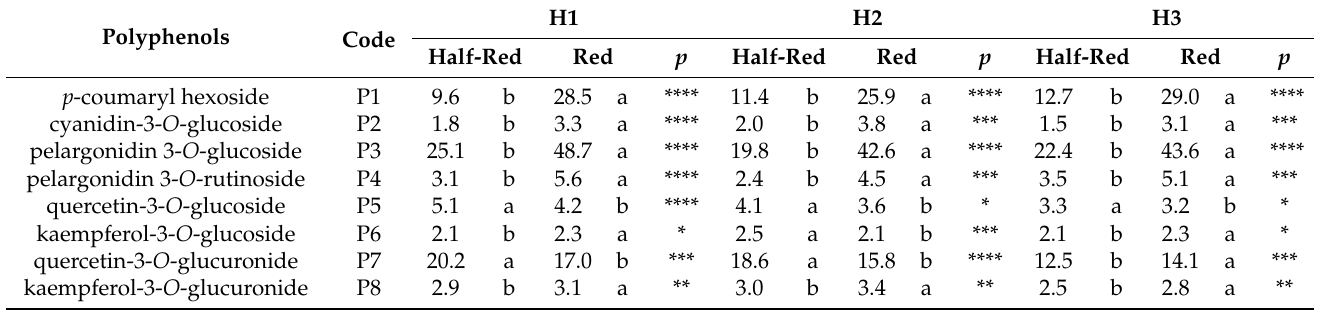
Table 2. Assignment and semi-quantitative determination of phenolic compounds measured in strawberries cv “Sabrosa” at two different ripening stages (half-red or red) and at three harvest times (H1, H2, H3). Polyphenols Code p -coumaryl hexoside cyanidin-3- O -glucoside pelargonidin 3- O -glucoside pelargonidin 3- O -rutinoside quercetin-3- O -glucoside kaempferol-3- O -glucoside kaempferol-3- O -glucuronide For each parameter the mean values followed by different letters (a, b) are significantly different ( p ≤ 0.05) according to least significant difference (LSD) test. Significance: ns = not significant; **** significant for p ≤ 0.0001; *** significant for p ≤ 0.001; ** significant for p ≤ 0.01; * significant for p ≤